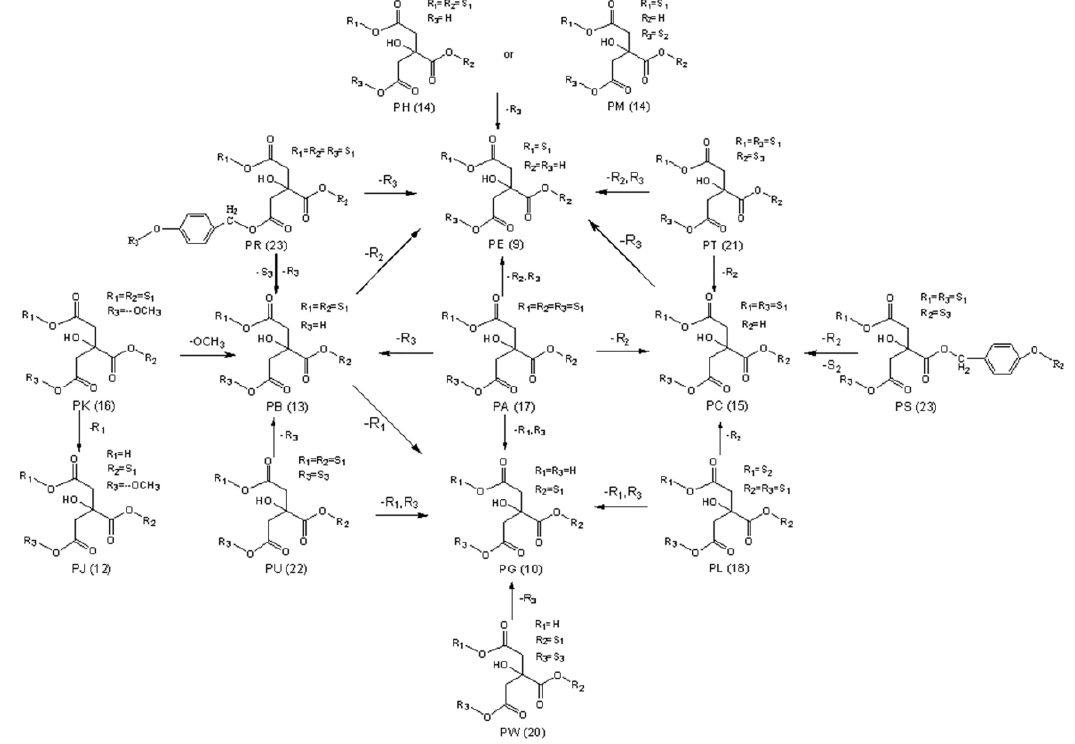
Figure 3. The hydrolysis pathways of parishins.